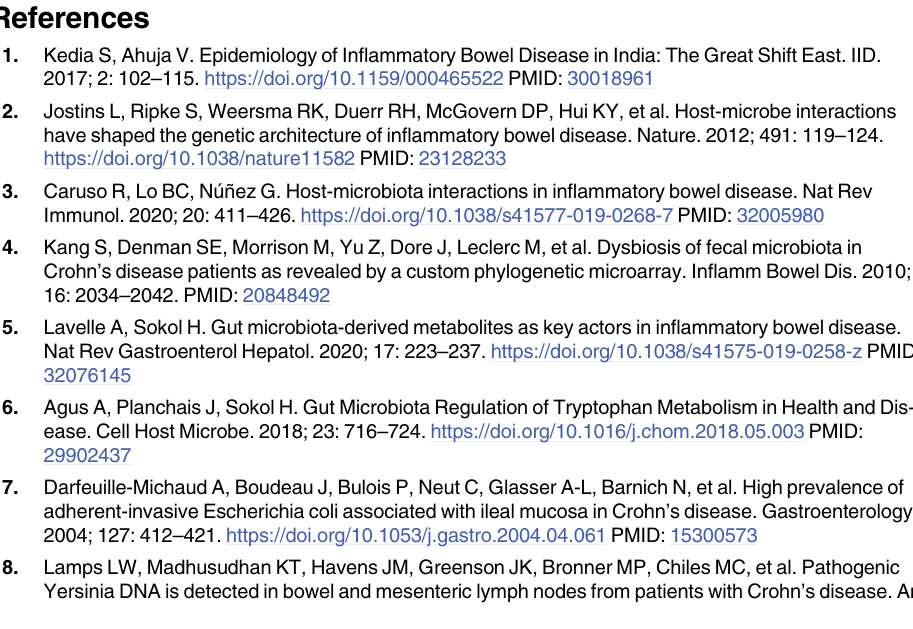
S1 Table. Primers used for detection of selected bacteria in the present study. a F and R indicate forward and reverse primers, respectively. S2 Table. Allele-specific primers used for genotyping. a F and R indicate forward and reverse primers respectively. b The polymorphic base is in bold; underlined letters indicate mis- matched